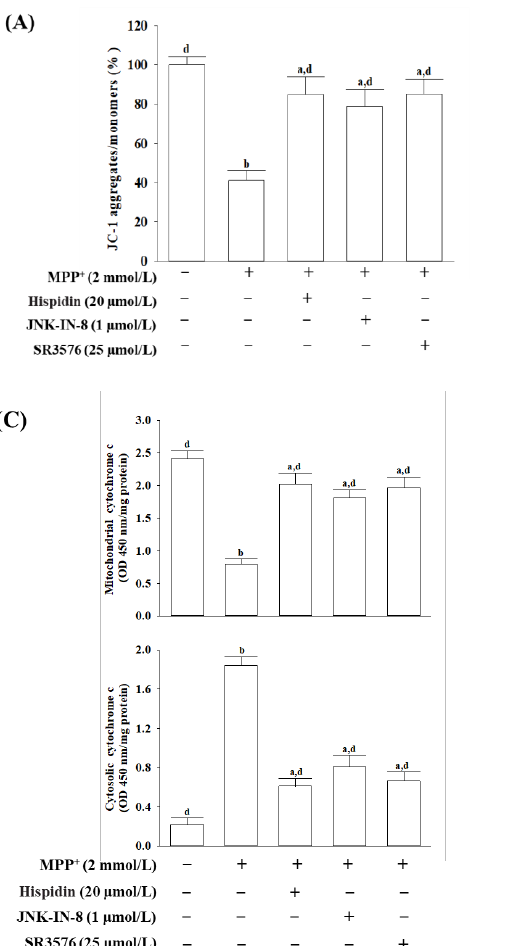
Figure 3. Hispidin prevents MS23.5 cells from MPP + -mediated mitochondrial dysfunction. MS23.5 cells were pretreated with hispidin (20 µ mol/L), JNK-IN-8 (1 µ mol/L), or SR3576 (25 µ mol/L) for 1 h and then exposed to 2 mmol/L MPP + for another 24 h. ( A ) ∆Ψ M has been measured with